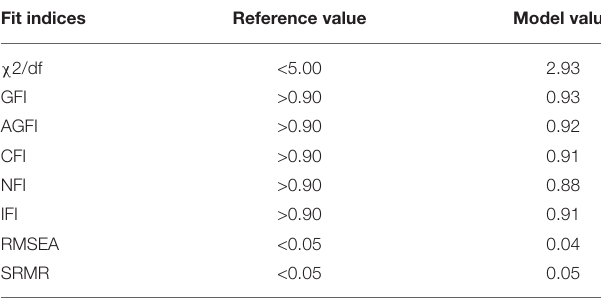
TABLE 5 | Results for SEM